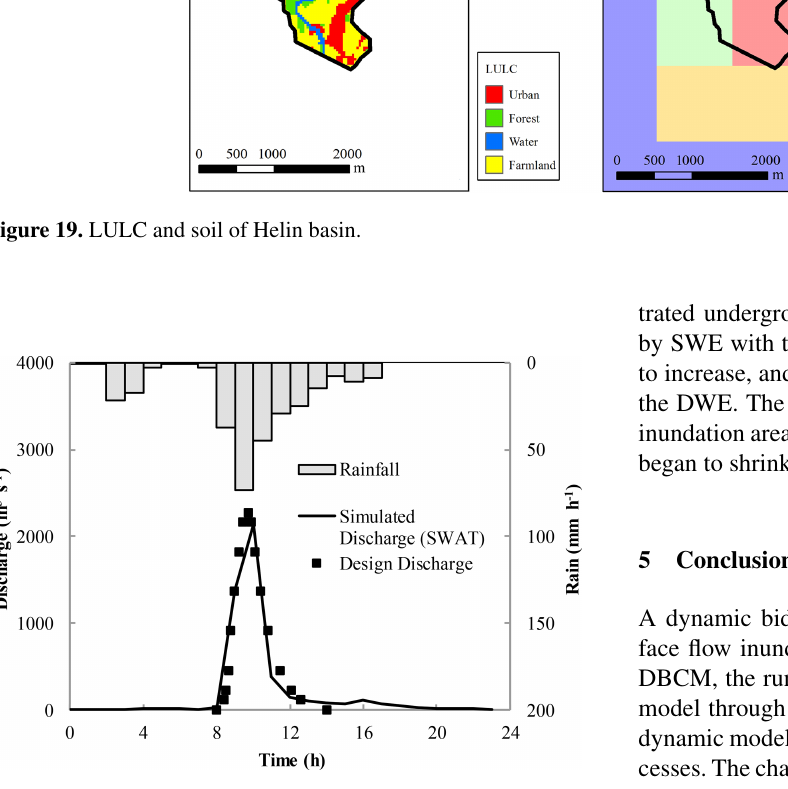
Figure 20. Design rain and flood with calculated flow in Helin basin outlet